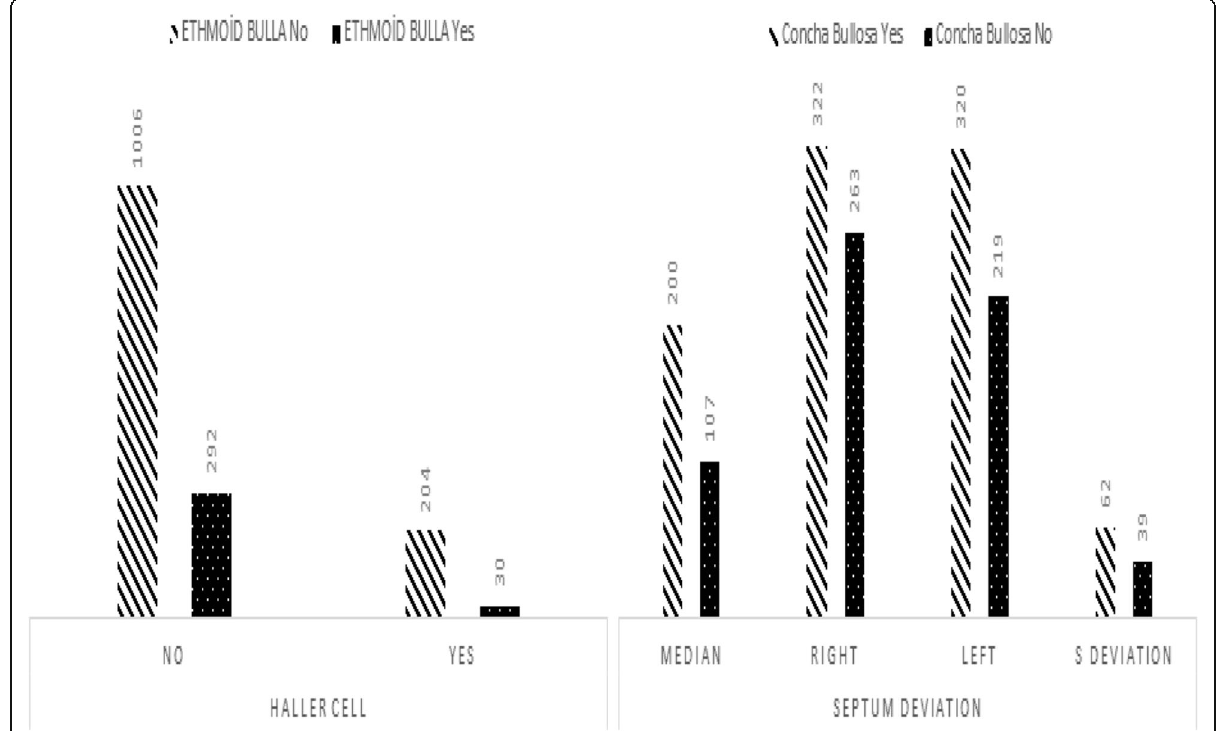
Fig. 1 Correlation of the observed anatomical variations with one